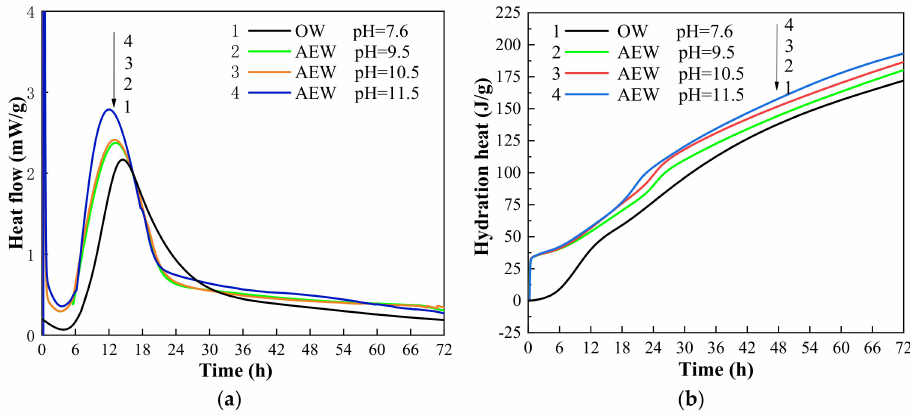
Figure 5. Test chart: ( a ) hydration heat flow diagram; ( b ) hydration heat